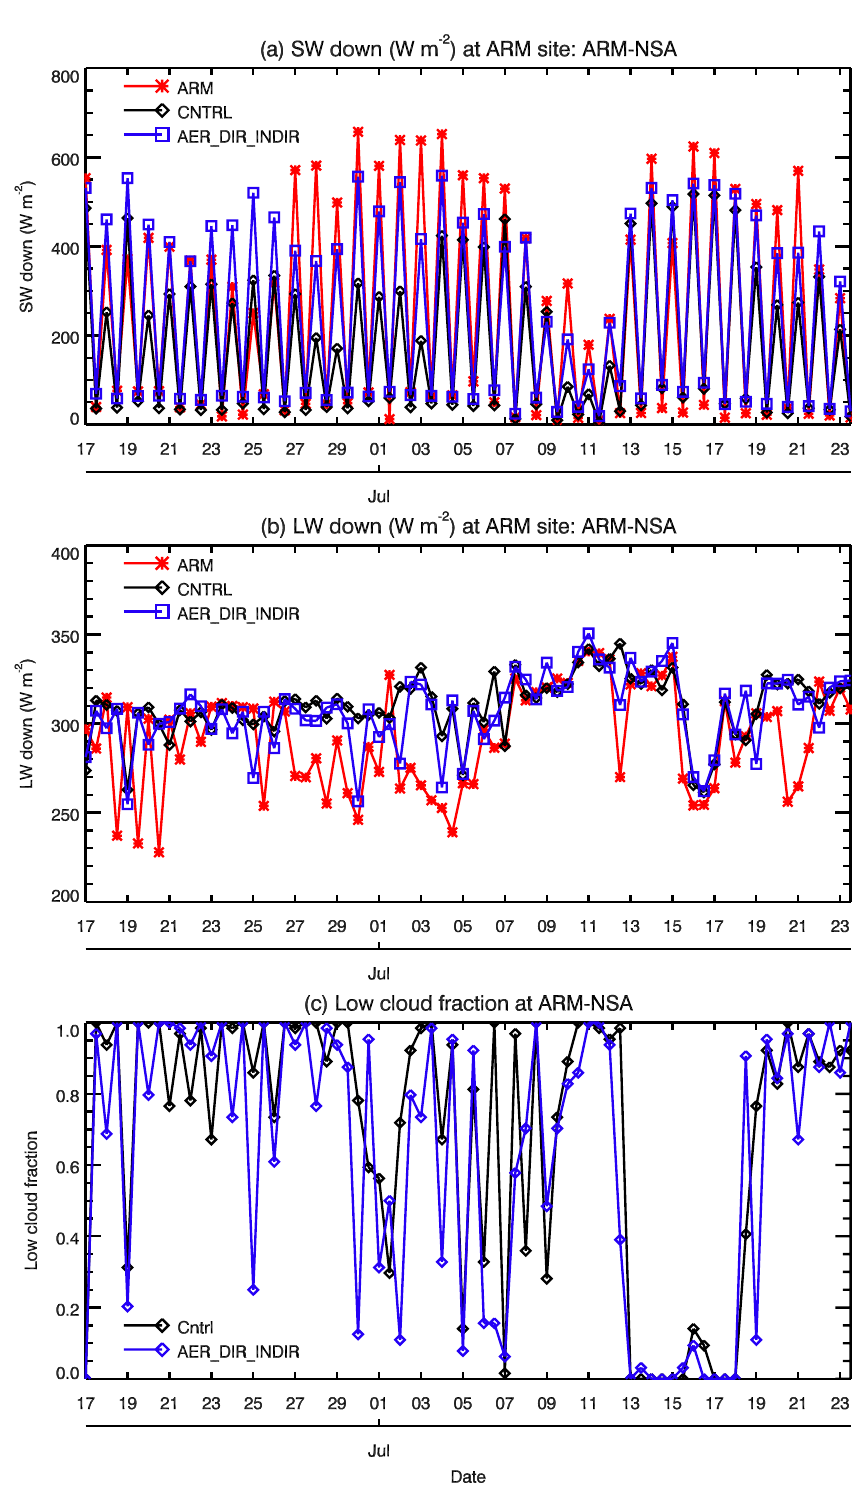
Fig. 12. Time series of (a) SW downward, (b) LW downward fluxes at the surface from CNTRL, AER_DIR_INDIR and ARM surface measurements at the North Slope of Alaska site, (c) low cloud amount from CNTRL and